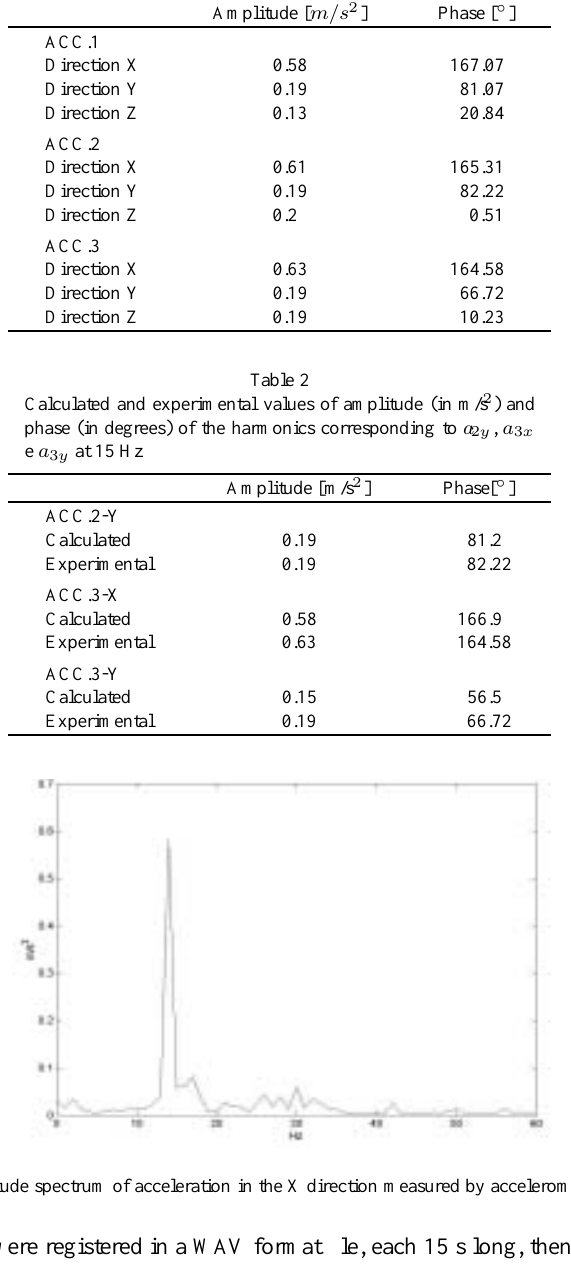
Table 1 Amplitude and phase of the acceleration harmonic at 15 Hz mea-